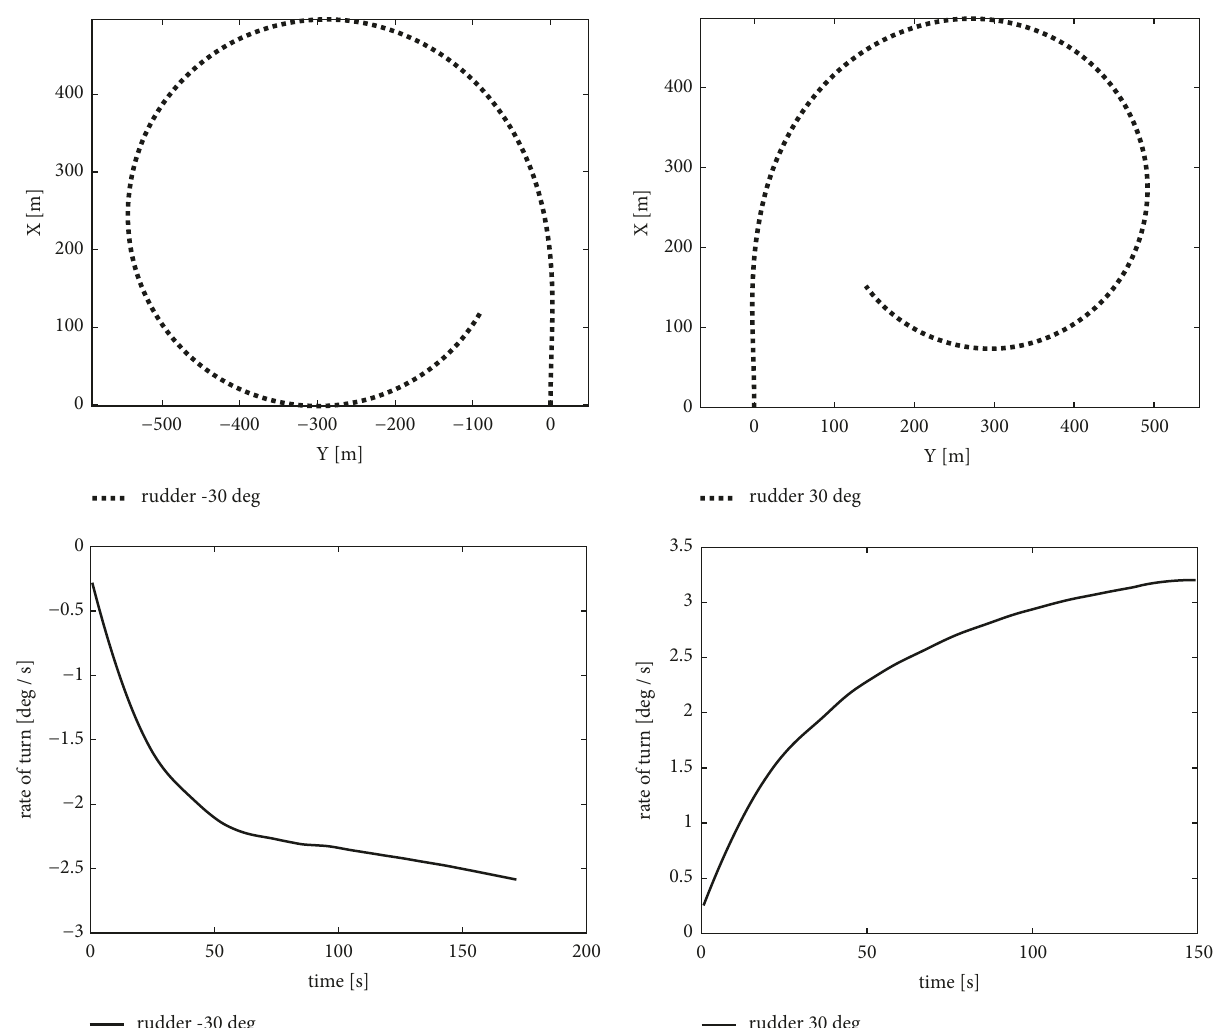
Figure 6: Results of LaiDyn simulations for the considered ro-pax for rudder setting 30